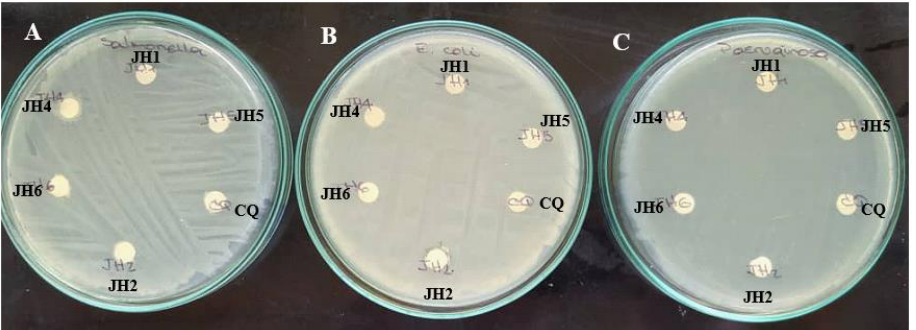
Figure 5. In vitro antimicrobial activity of bis-THTTs (JH1, JH2, JH4, JH5 and JH6) on Gram-positive bacteria. ( A ): Staphylococcus aureus ATCC 25923, ( B ): Listeria monocytogenes CVCM 446. CQ was used as the positive control.